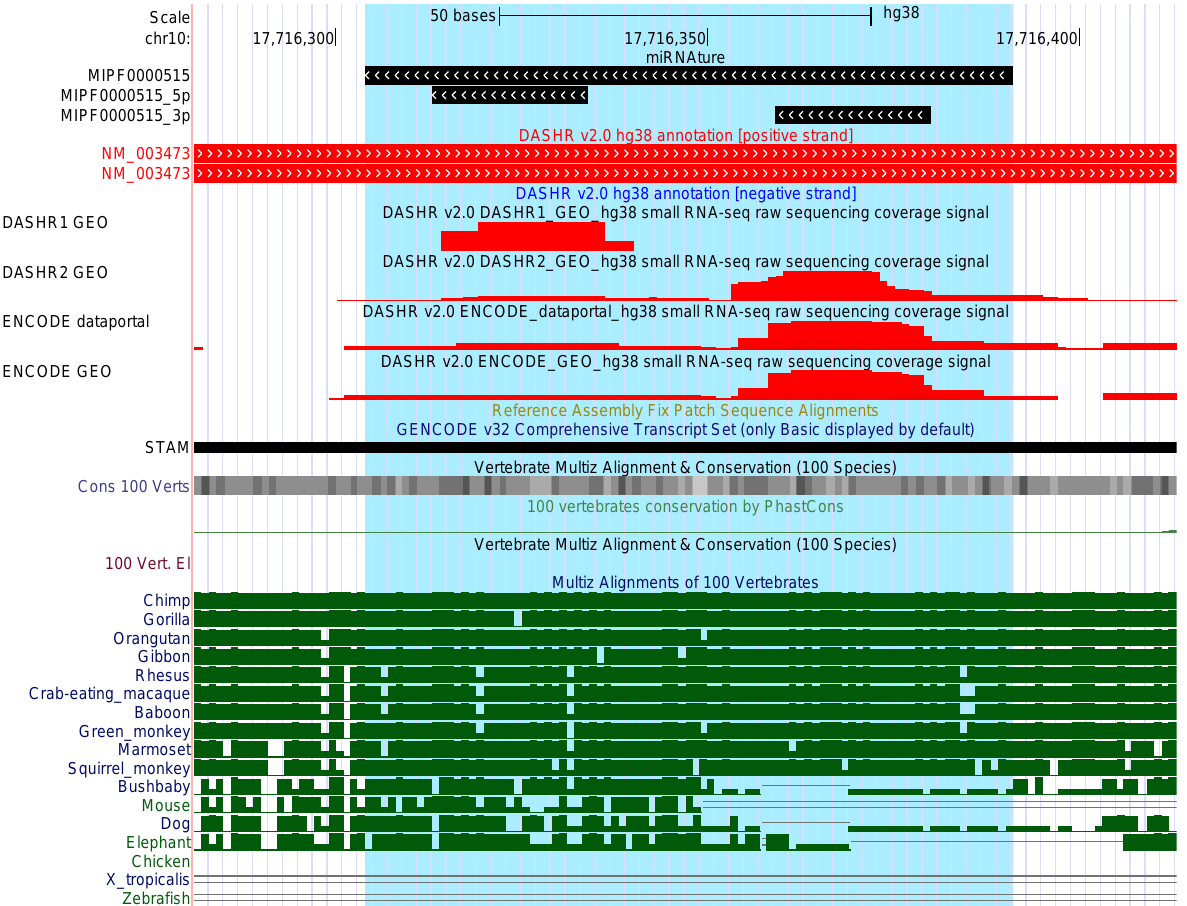
Figure 2. Crossed annotation and expression patterns overlapping in the same region where a loci of mir-580 was detected by miRNAture . Red tracks correspond to sRNA-Seq mapped reads, reported from